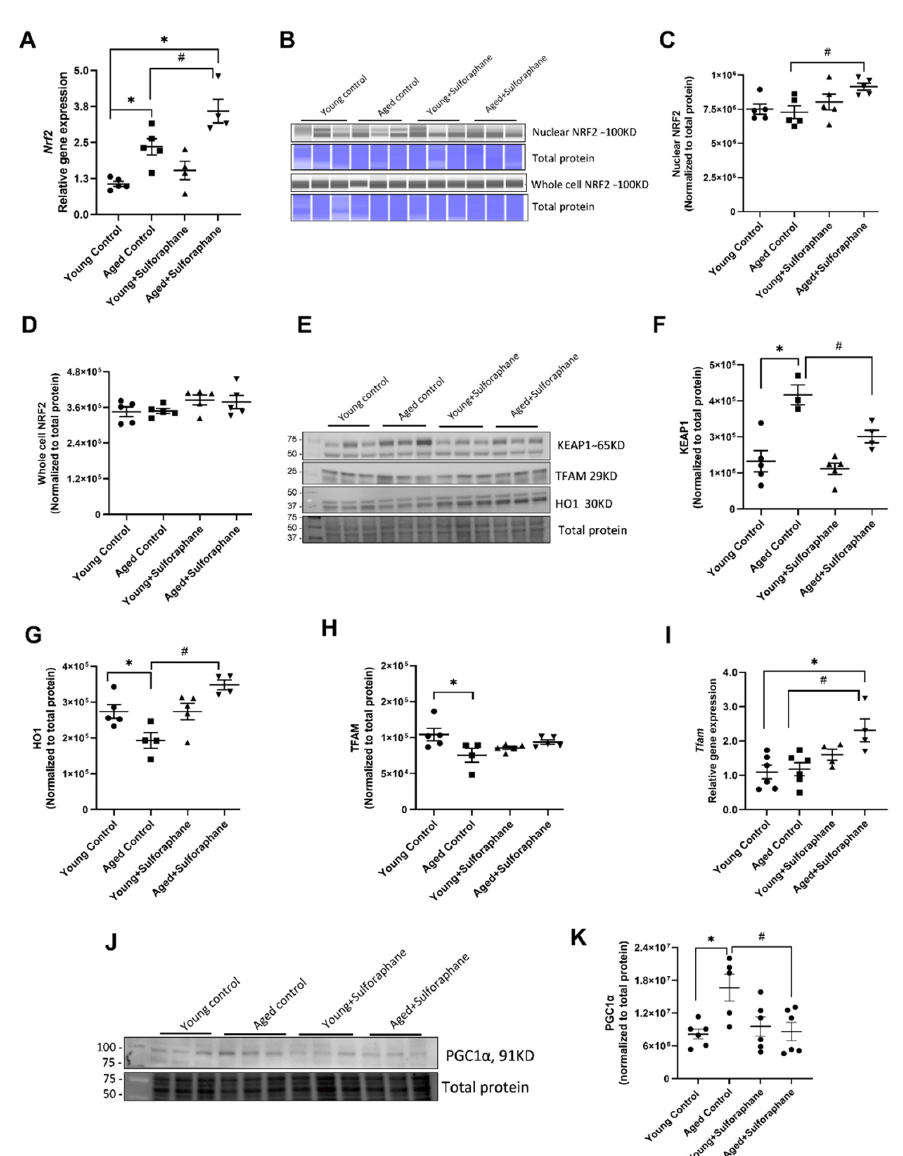
Figure 1. Sulforaphane treatment increases renal cortical NRF2 expression and decreases KEAP1 protein expression in aged rats. ( A ) Kidney cortical Nrf2 mRNA expression, data normalized to 18 s RNA. Results are presented as mean ± SEM, n = 4–5 rats. ( B ) Nuclear and whole-cell NRF2 Western blot images along with total protein. ( C , D ) NRF2 protein measured in the nuclear extract and whole-cell extract of kidney cortical tissue, by Jess analysis, Band densities presented as mean ± SEM, n = 3–5 rats. Data normalized to total protein stain. ( E ) Western blot images of KEAP1, cortical transcription factor A, mitochondrial (TFAM), and cortical hemeoxygenase 1 (HO1) along with total protein. ( F ) Cortical KEAP1 protein expression. ( G ) HO1 protein expression. ( H ) TFAM protein expression. Band densities presented as mean ± SEM, n = 3–5 rats. Data normalized to total protein. ( I ) Tfam gene expression, Data normalized to 18 s RNA, n = 3–5 rats. ( J , K ) images of cortical PGC1 α Western blot and PGC1 α protein expression measured in young control (young F344 rats kept on tap water); aged control (aged F344 rats kept on tap water); young+sulforaphane (sulforaphane,15 mg/kg body wt/day in drinking water); aged+sulforaphane. Band densities presented as mean ± SEM, n = 5–6 rats. Data normalized to total protein. * p < 0.05 significantly different from young control rats; # p < 0.05 significantly different from aged control rats, using 1-way ANOVA followed by Newman–Keuls post-hoc test.